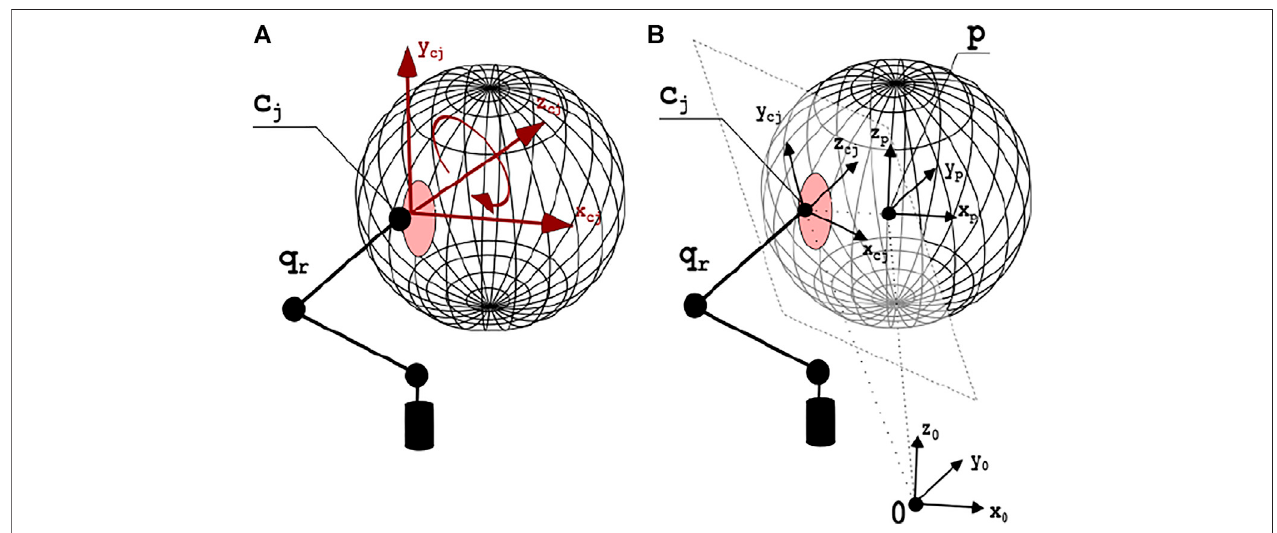
FIGURE 7 | In (A) , the contact model with one fi nger. The red area surrounding the contact point c j is the deformation zone. Red arrows display the directions in which motion is not allowed, thus it is possible to apply force or torques. In (B) , the contact surface and the axes of the main reference systems are depicted.